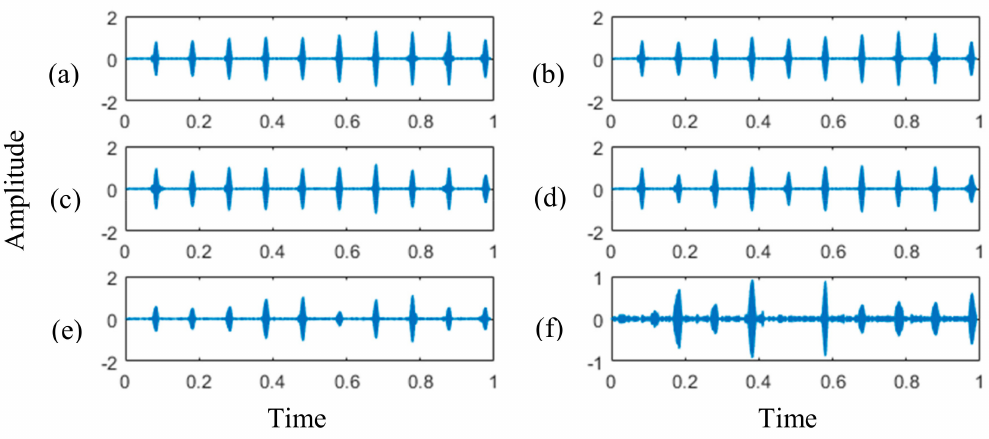
Figure 10. The impulse component with EWT method, ( a ) no noise, ( b ) 10 dB, ( c ) 5 dB, ( d ) 0 dB, ( e ) − 5 dB, and ( f ) − 10 dB of